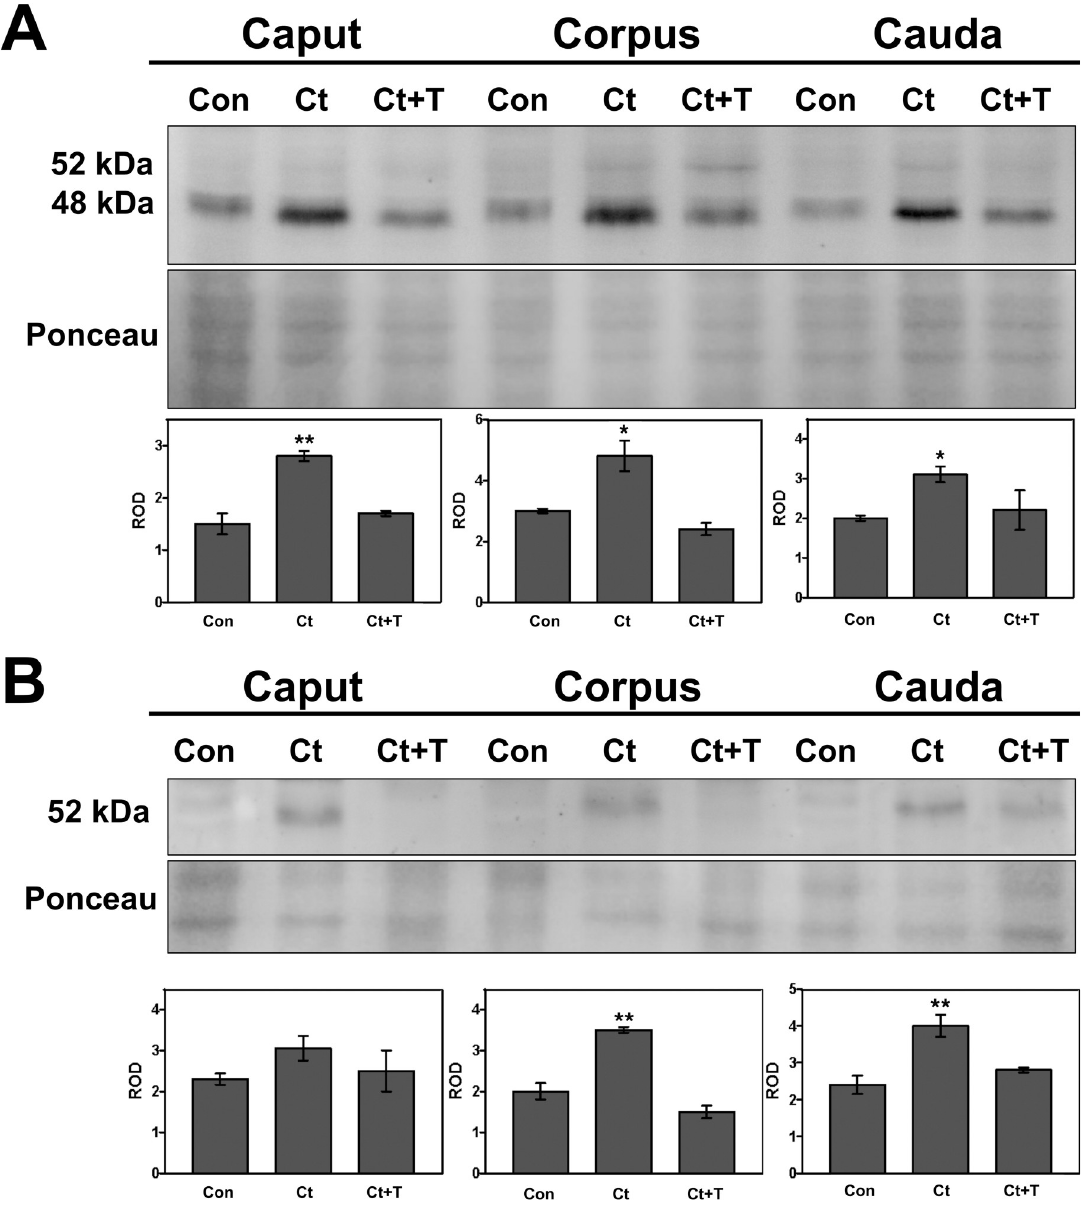
Fig 4. Immunodetection of cathepsin D in whole epididymal tissue (A) and luminal fluid (B) of the epididymis from control (Con), castrated (Ct) and castrated with testosterone supplementation (Ct+T) animals. Three regions of the epididymis were examined, i.e. IS/ caput, corpus and cauda. Bands of 52 kDa and 48 kDa corresponding to immature and intermediate forms of CatD, respectively, are indicated. The figure shows a representative immunoblot for each region and experimental condition and the quantification of the bands in each case (intermediate CatD for tissues and immature form in fluids). Bars represent the means of relative optical density (ROD) ± SE from three independent experiments. ( � ) and ( �� ) are significant differences from the control (p < 0.05 and p < 0.01 respectively, obtained by Tukey’s multiple comparisons Test). Ponceau staining was used as loading